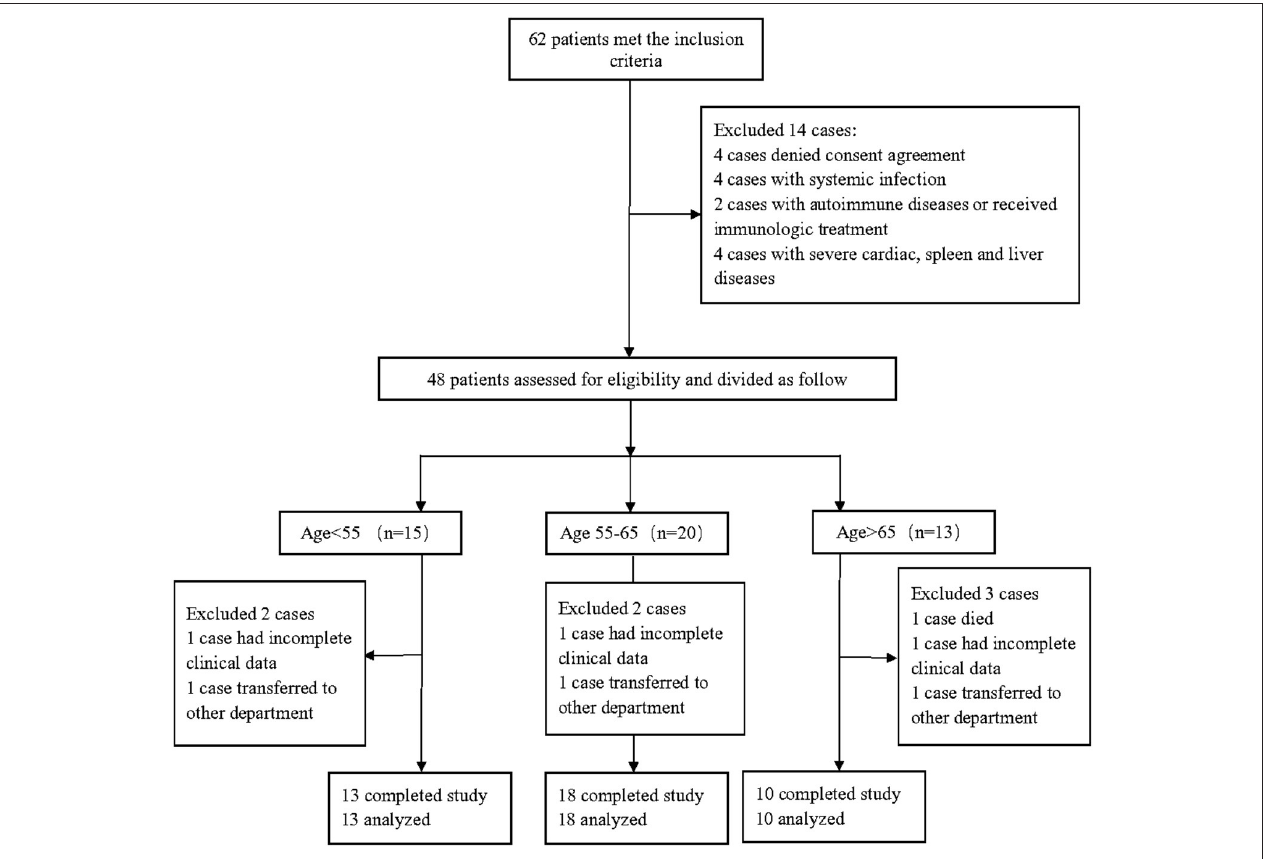
FIGURE 1 | Schematic diagram of the clinical trial profile.